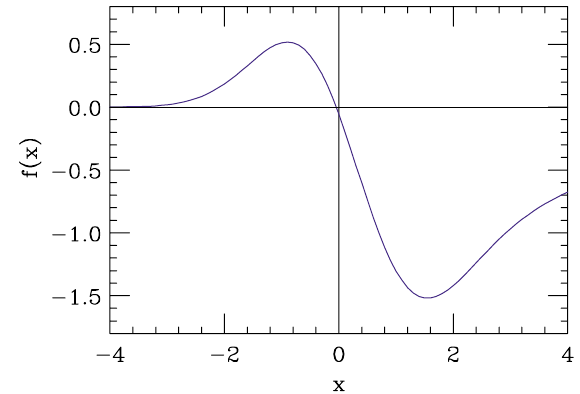
FIG. 5. (Color) A sketch of the model for the transverse wake calculation. The beam pipe and beam are both cylindrically